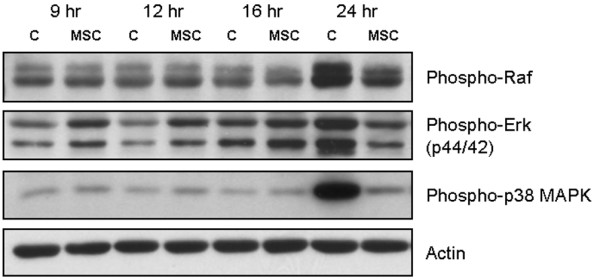
Effect of Se-methylselenocysteine (MSC) on phospho-Raf, phospho-ERK, phosphorylated p38 mitogen-activated protein kinase (phospho-p38 MAPK) levels in TM6 cells. TM6 cells were synchronized and treated with 50 μM MSC as described in Fig. 1. Equal amounts of TM6 lysates (50 μg of protein) were loaded on each lane. Immunoblots were probed with anti-phospho-Raf, anti-phospho-ERK, anti-phospho-p38 MAPK and anti-actin as described in the Materials and methods section. Levels of the phosphoproteins remained unchanged at 9, 12 and 16 hours but at 24 hours the phosphorylated proteins decreased in MSC-treated cells.